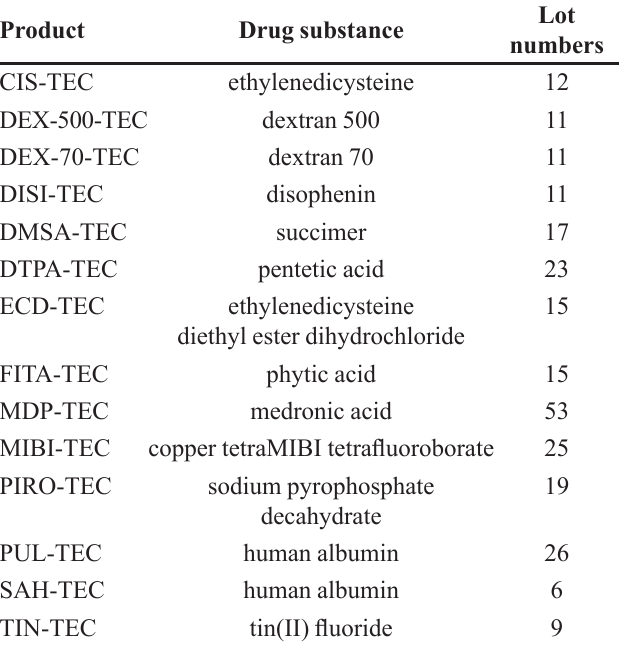
, f f and WCI calculation for O D , S